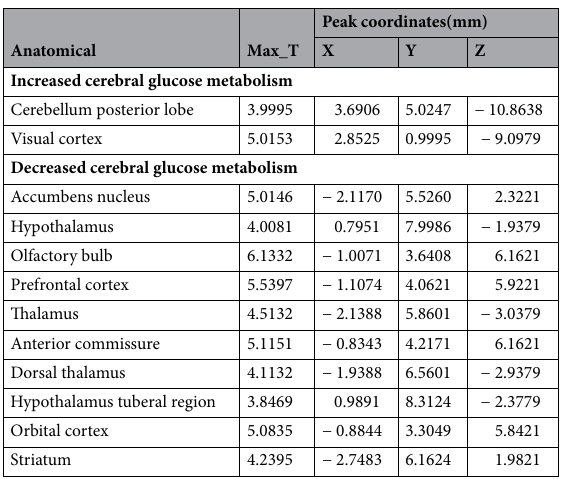
Table 3. Changes in brain glucose metabolism in the MA group versus the SHR group.